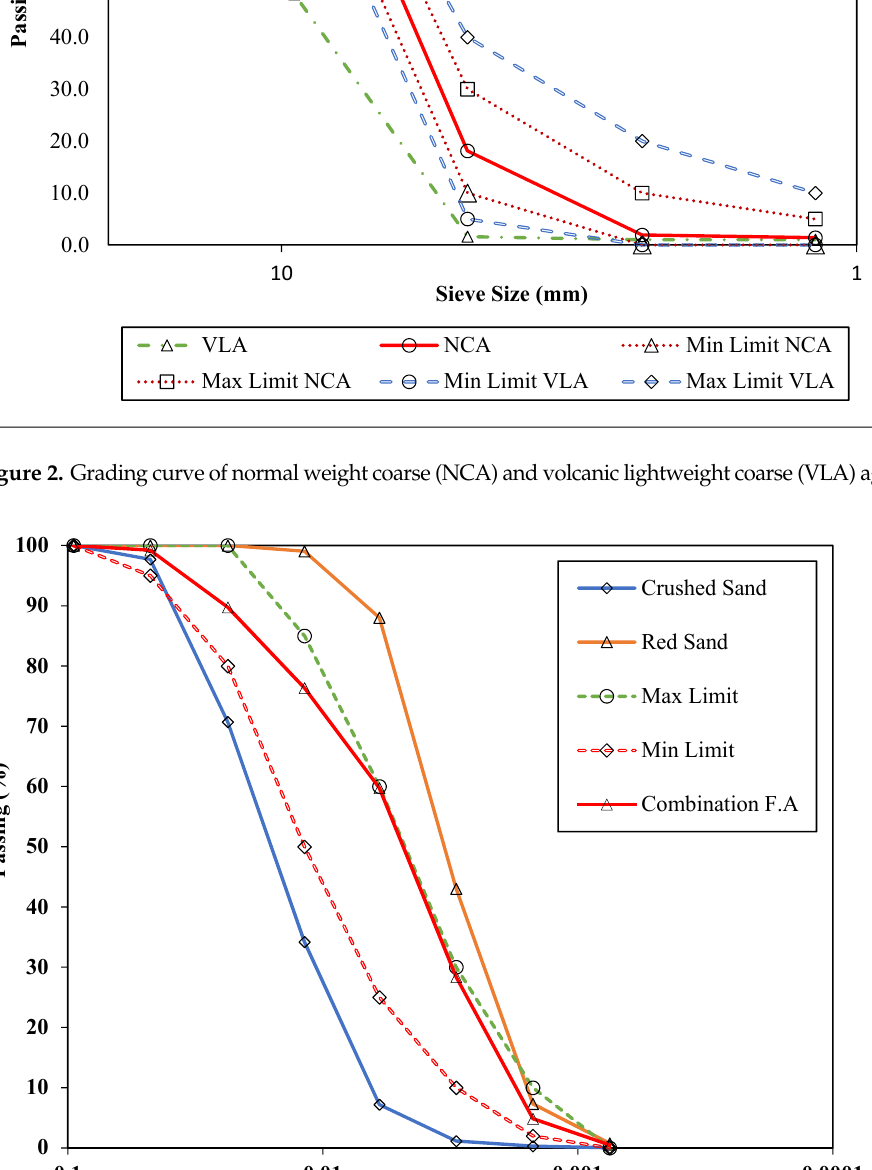
Materials 2021 , 14 , x FOR PEER REVIEW 5 of 21